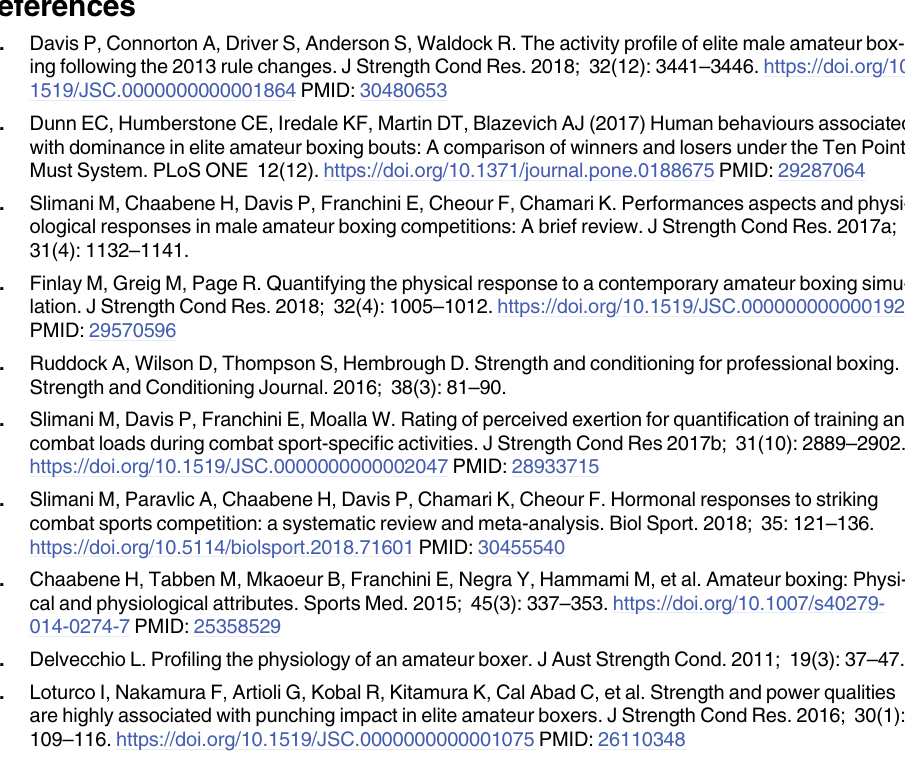
S1 Table. Physical preparation practices of amateur boxers survey. Survey